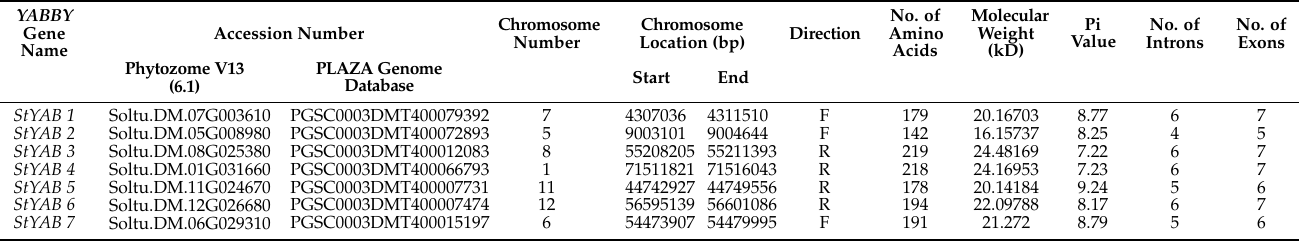
chromosome number and location, gene direction, amino acid sequence length, molecular weight, isoelectric point (Pi value), no. of introns and